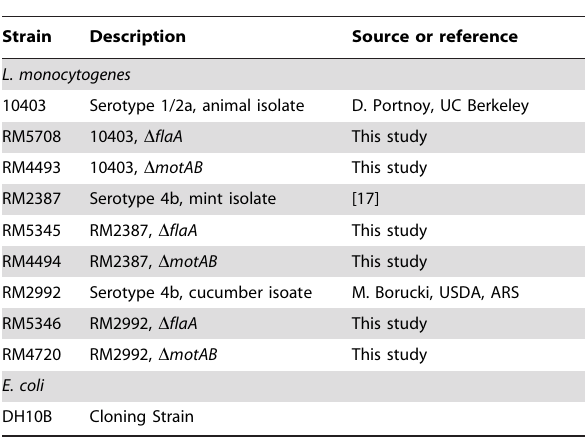
Table 4. Strains used in this study.